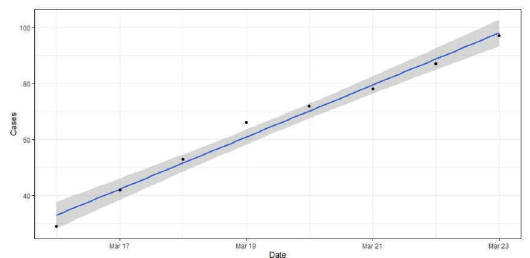
Figure 3: Total number of cases reported each day